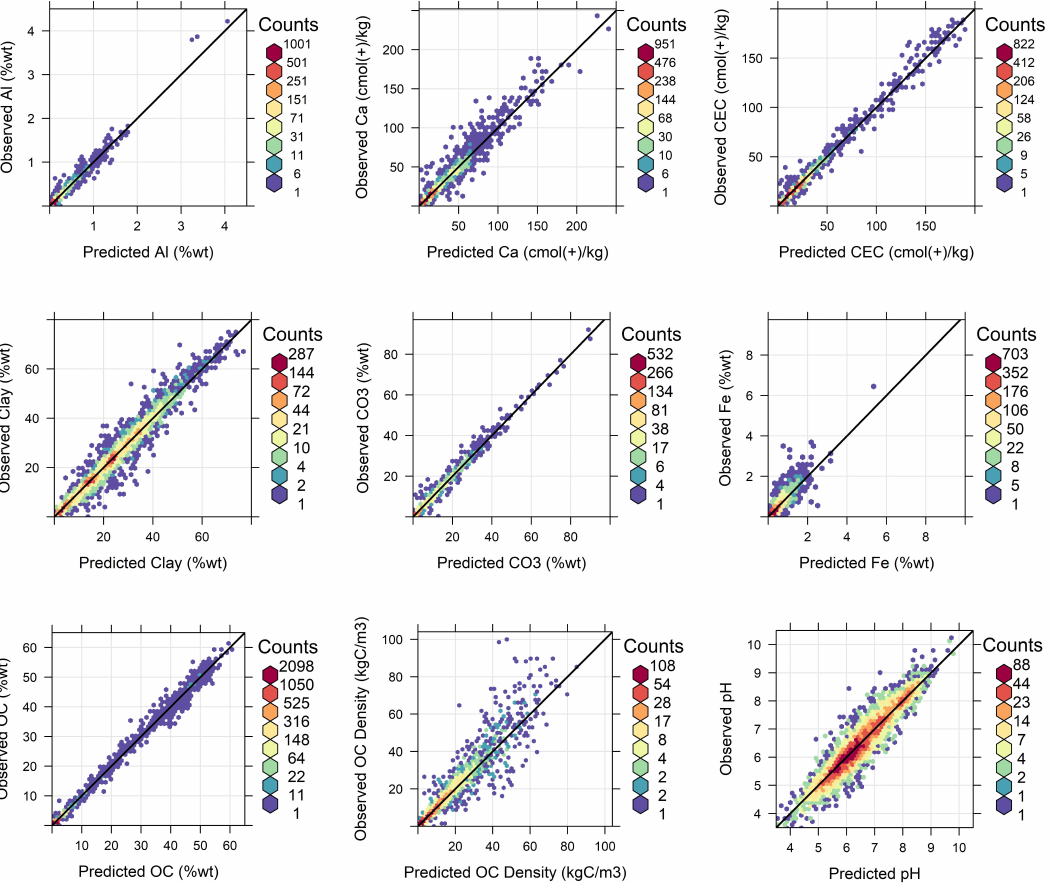
Figure 2. Comparison of the memory-based learner (MBL) model predictions with an independent validation set of laboratory-measured Al, Ca, CEC, clay, CO 3 , Fe, OC, OCD and